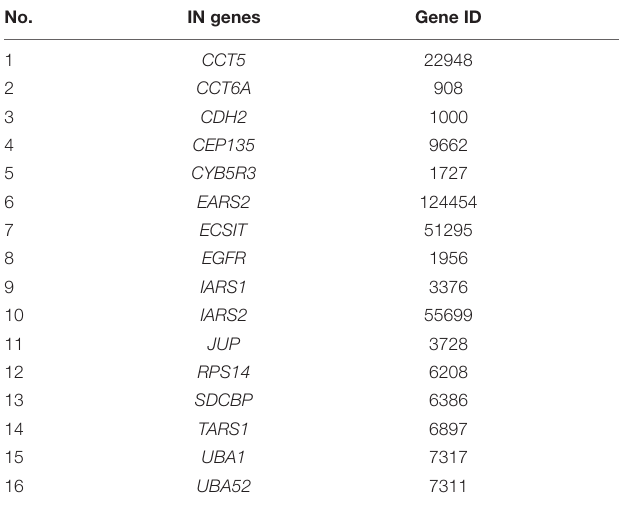
TABLE 1 | Significant intermediate (IN) genes overlapping three